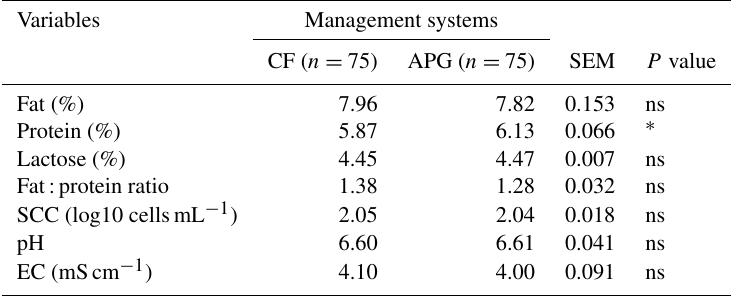
Table 2. Milk chemical composition of the Awassi ewes in the CF and APG systems. Variables Management systems CF ( n =